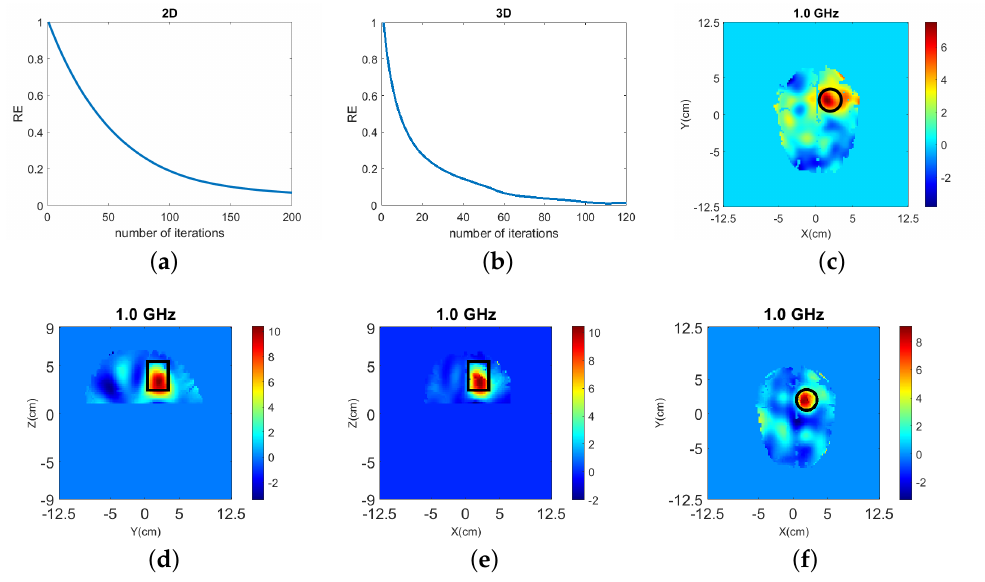
Figure 8. Reconstructions of “Case I” when RE converges: 2-D with 200 iterations and 3-D with 120 iterations. ( a , b ) Residual error plot for 2-D and 3-D, respectively. ( c ) Contrast (cid:60) ( δ ε ) for 2-D reconstruction. ( d – f ) Contrast (cid:60) ( δ ε ) for the y-z, x-z, and x-y slices of 3-D reconstruction, respectively.